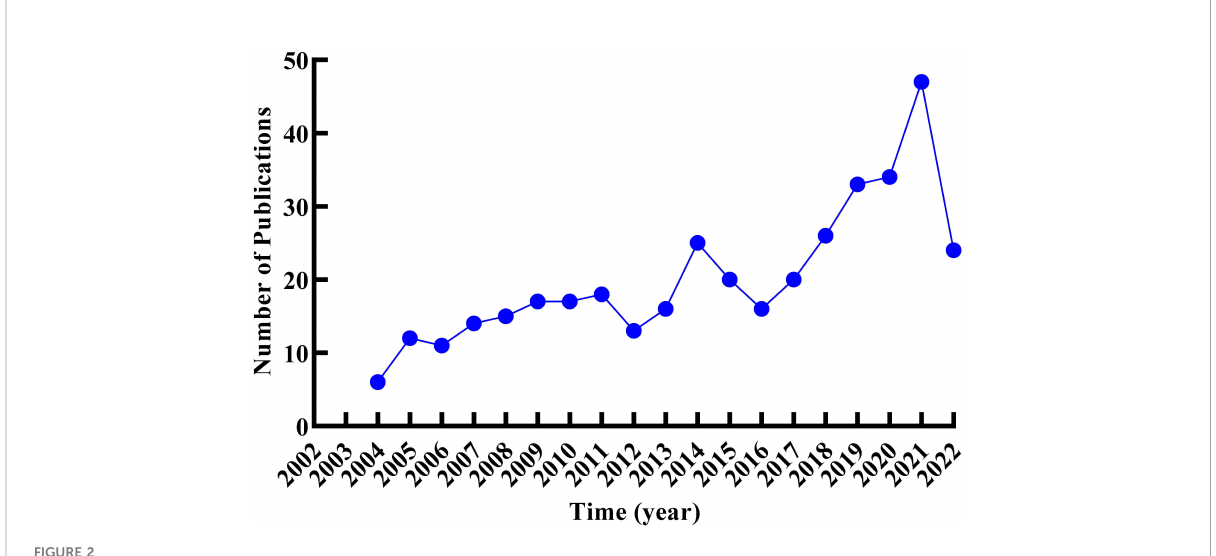
FIGURE 2 Trends of the annual publications related to RNA methylation in DM and its complications.